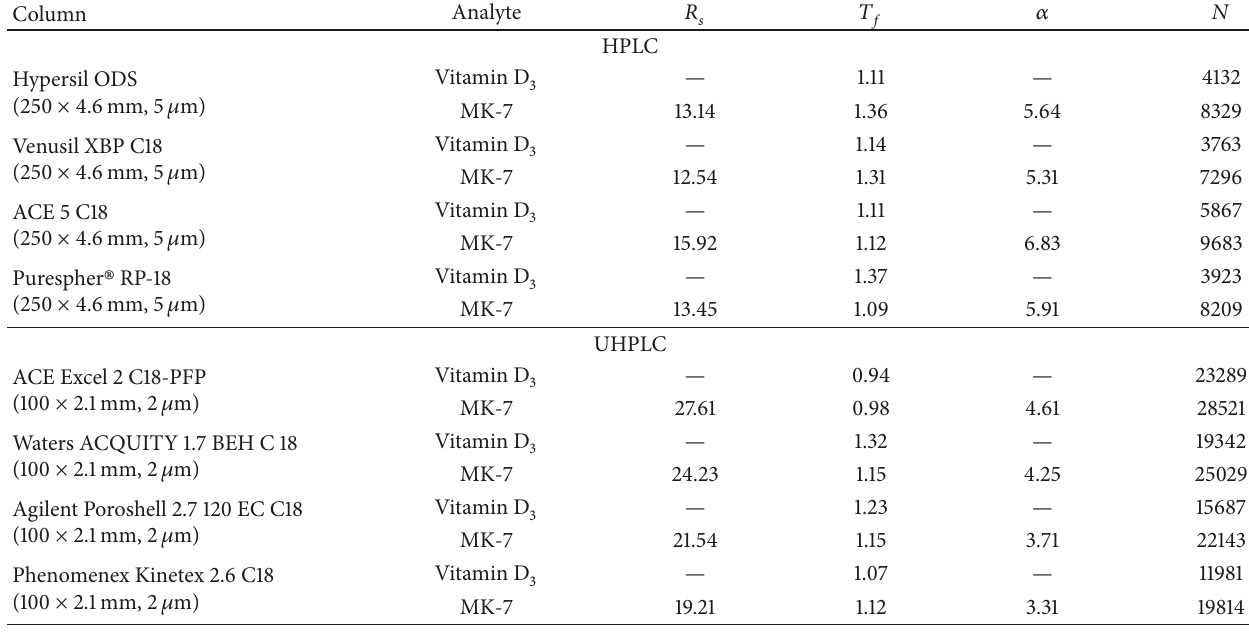
Table 1: Results of tested stationary phase.